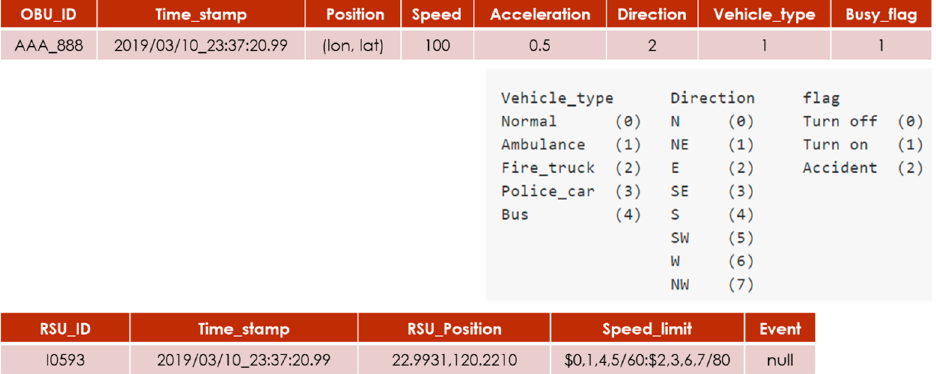
Figure 7. Vehicular network communication protocol.